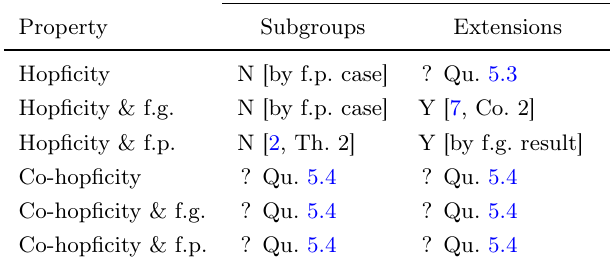
Table 1. Summary, for groups, of the preservation of hopficity and co-hopficity on passing to finite index subgroups and extensions. [ Key: f.g. = finite generation; f.p. = finite presentation; Y = property is preserved; N = property is not preserved in general; ? = open